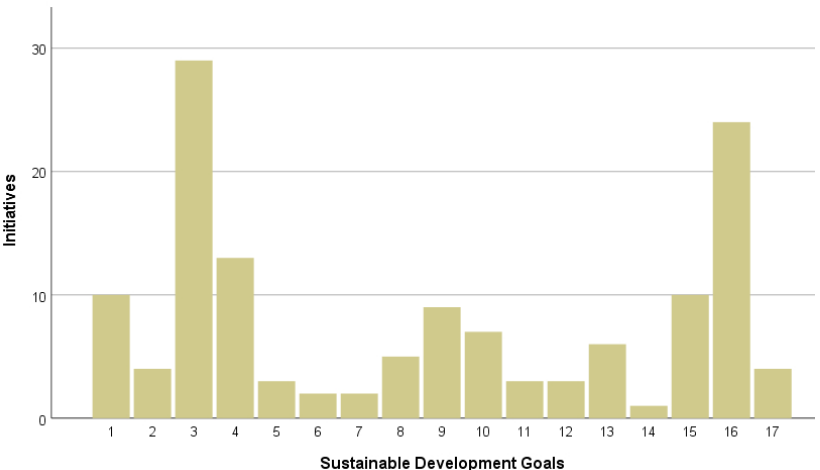
Figure 2. Number of project initiatives that fully or partially link AI to the SDGs. Note. Adapted from [38].